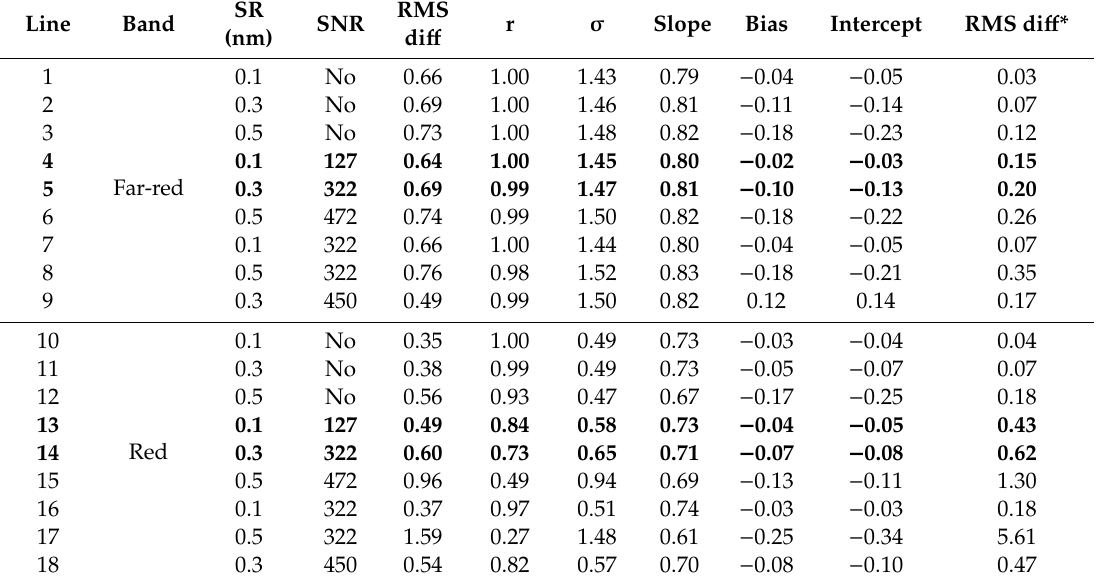
Table 5. Statistical parameters for the comparisons between the retrieved and true fluorescence derived from the simulated dataset with di ff erent combinations of SNR and SR. The statistical parameters include the root-mean-squared di ff erence (RMS di ff ), correlation coe ffi cient (r), standard deviation ( σ ), bias between the retrieved and true fluorescence, slope and intercept of the linear fit, and the RMS di ff erence after correction for systematic errors (RMS di ff *). ‘No’ in the SNR column indicates that the simulated data do not include noise signals. The units used in columns with bold headings are mW m − 2 sr − 1 nm − 1 . In addition, the bold rows represent the best statistical results for simulations with an SR of 0.1 nm and SNR of 127 and those with current specifications (SR of 0.3 nm and SNR of 322) of SIFIS at both far-red and red